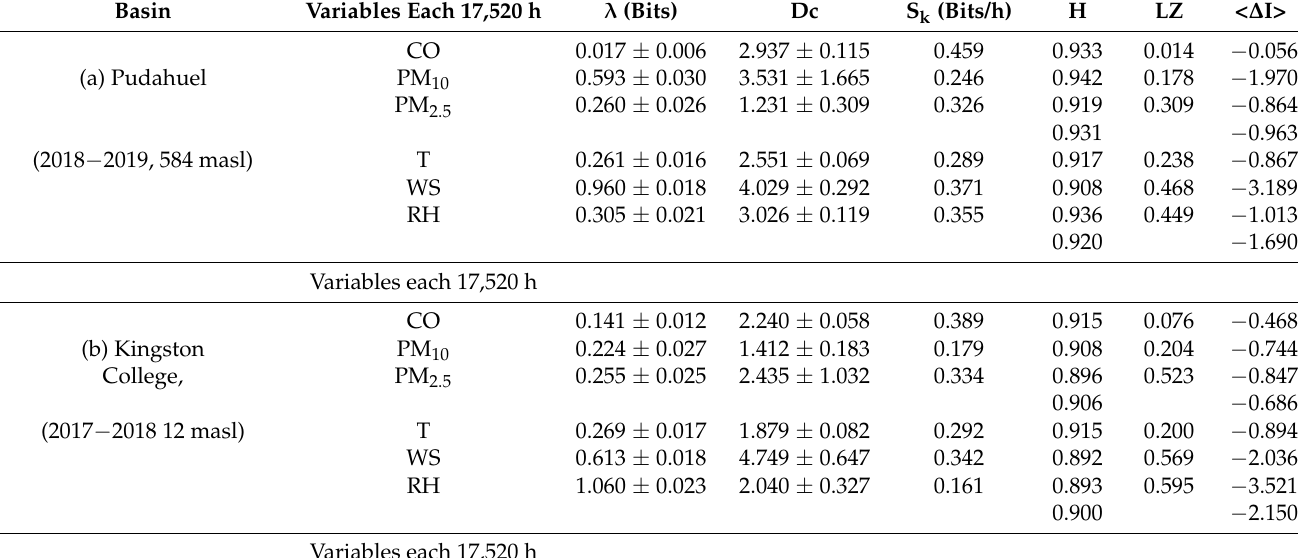
Table 4. Table presents the summary of the calculations, where h is hour and masl is meters above sea